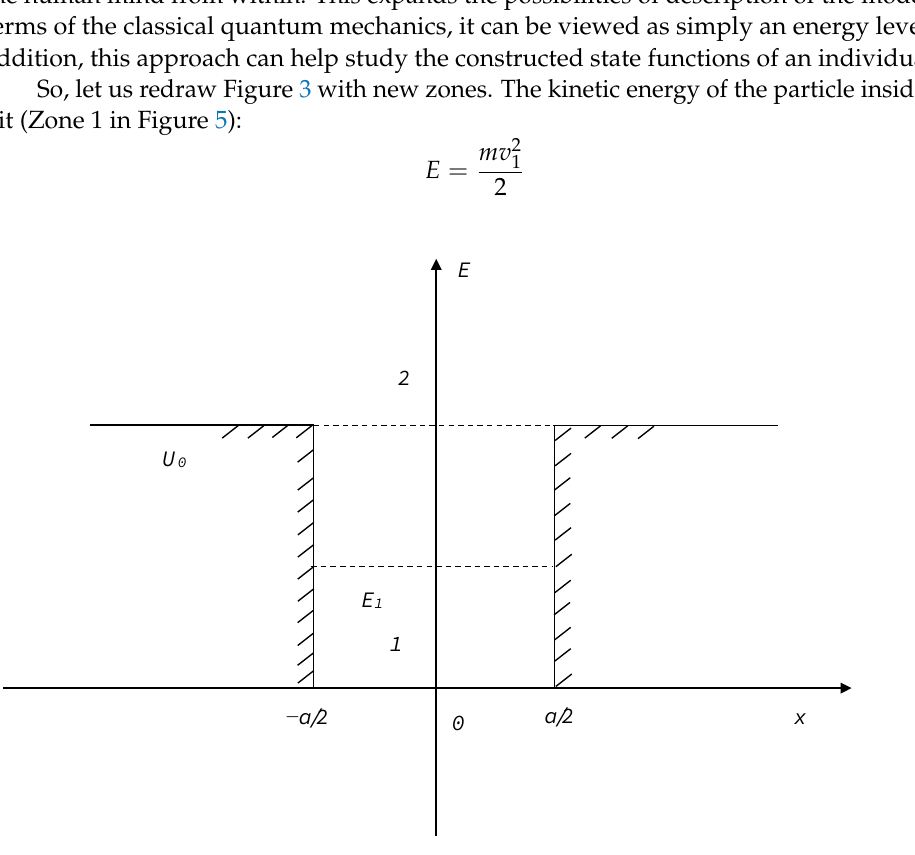
Figure 5. One-dimensional potential pit with finite walls for self-oscillating case. Zone 1—inside the pit, Zone 2—outside.